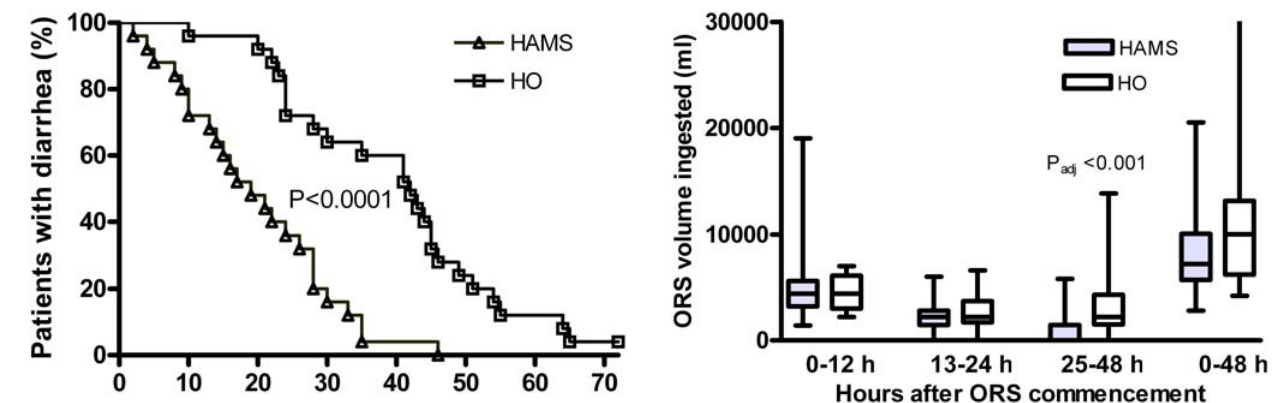
Table 3. Biochemical parameters after therapy and other measures in the two study arms.